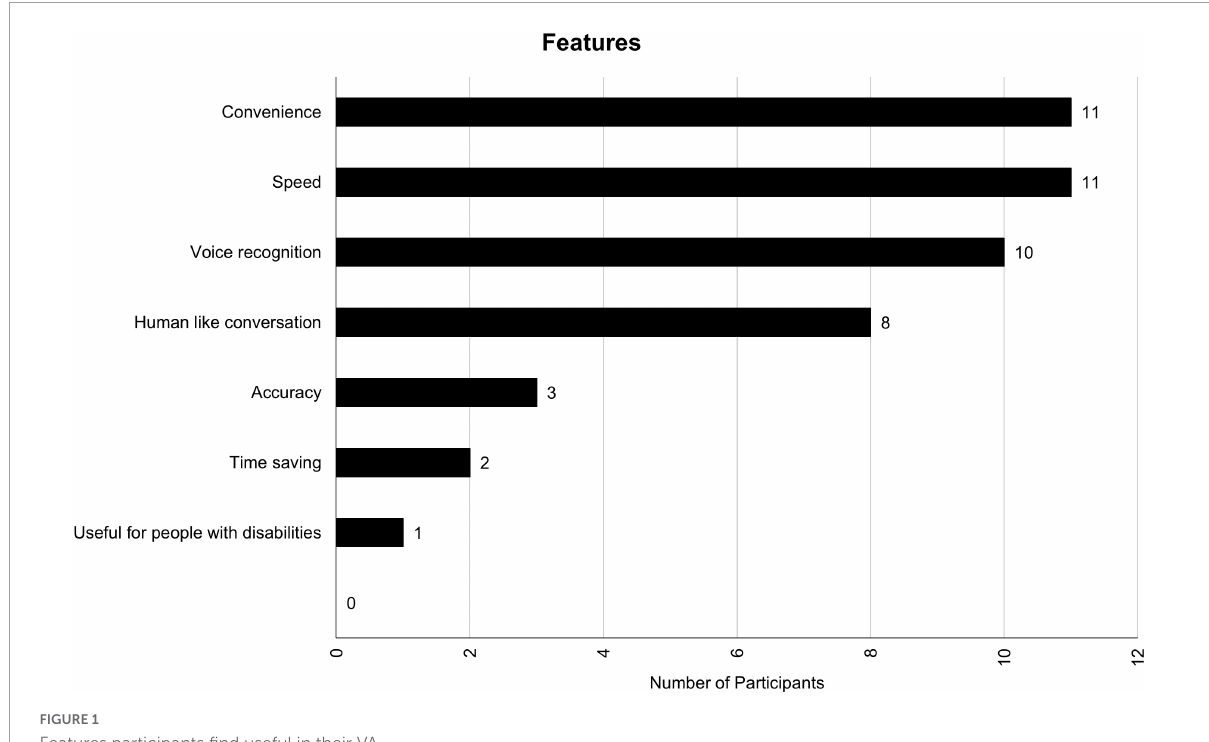
FIGURE1 Features participants find useful in their VA.